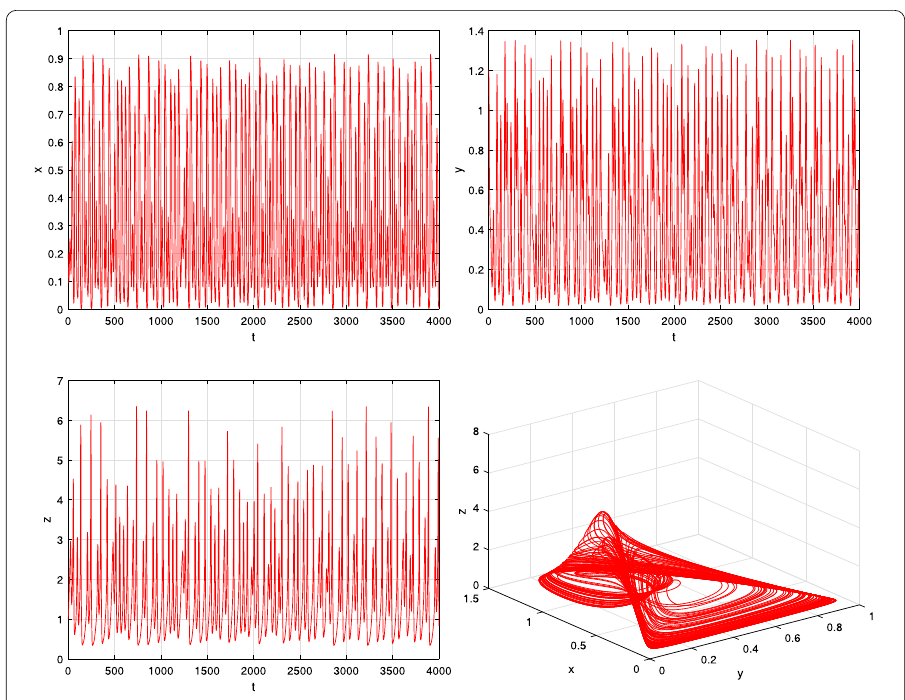
Figure 1 The trajectories and graphs of system (1.3) with τ = 0, where w 1 = 1.4, w 2 = 5, w 3 = 8, w 4 = 1, w 5 = 0.16, w 6 = 0.1, w 7 = 0.1, w 8 = 0.5, w 9 = 8, w 10 = 8. System (1.3) has a chaotic